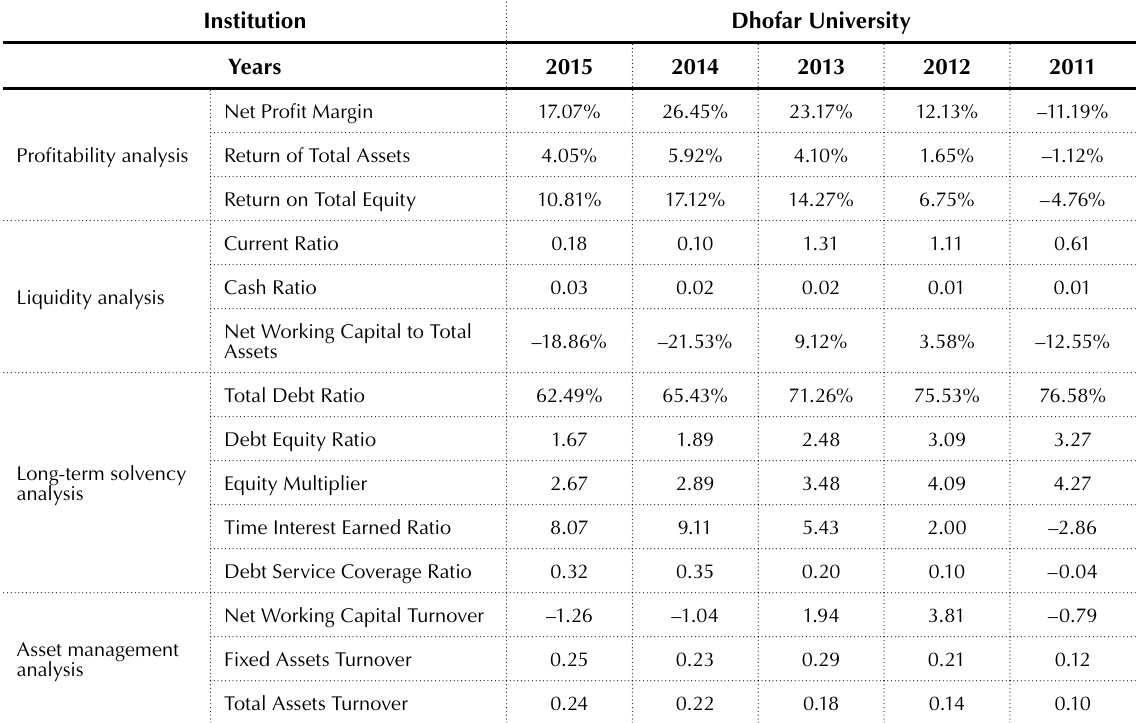
key financial ratios. The ratios are grouped into four facets: (1) profitability analysis (Martinez et al., 2006) which measures overall performance of the higher education institutions and its effi- ciency of managing their assets, liabilities and eq- uity; (2) liquidity analysis (Sree, 2015) which mea- sures the ability to meet cash needs as they arise; (3) long-term solvency analysis (Davies, 2002) Table 4. Five years financial ratios analysis for Dhofar